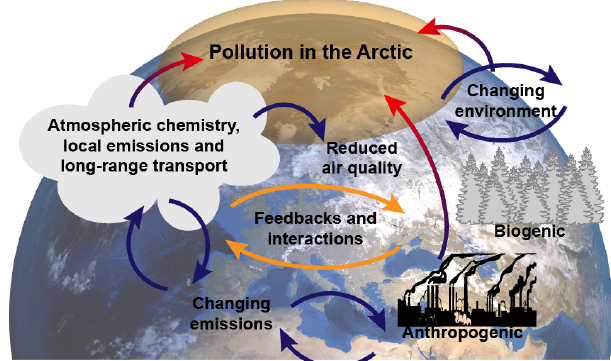
Figure 1. Atmospheric concentrations of pollutants and their life cycles in high latitudes are affected by local and regional anthro- pogenic activities and long-range transport from lower latitudes. Pollutant distributions and life cycles are modulated by transport patterns, changes in the biosphere, increased natural resource ex- traction, and increased shipping in the Arctic Sea. Various feed- backs and interactions can either speed up or hinder the